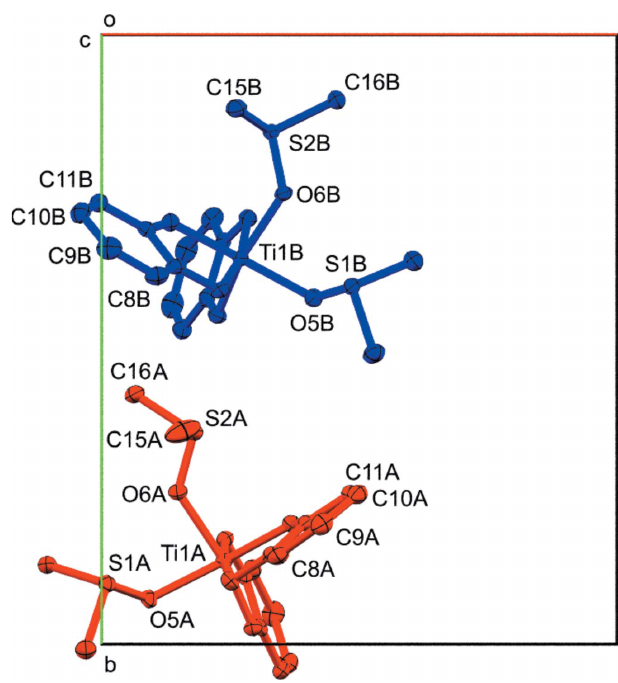
Figure 6 View of 3 down the c axis, showing the modulation by pseudo- Pbca symmetry. Molecules color coded by symmetry equivalence (red: molecule A , blue molecule B ). Atom labels included for Ti, DMSO S and O atoms, and for C atoms with the largest modulation. 50% probability ellipsoids.